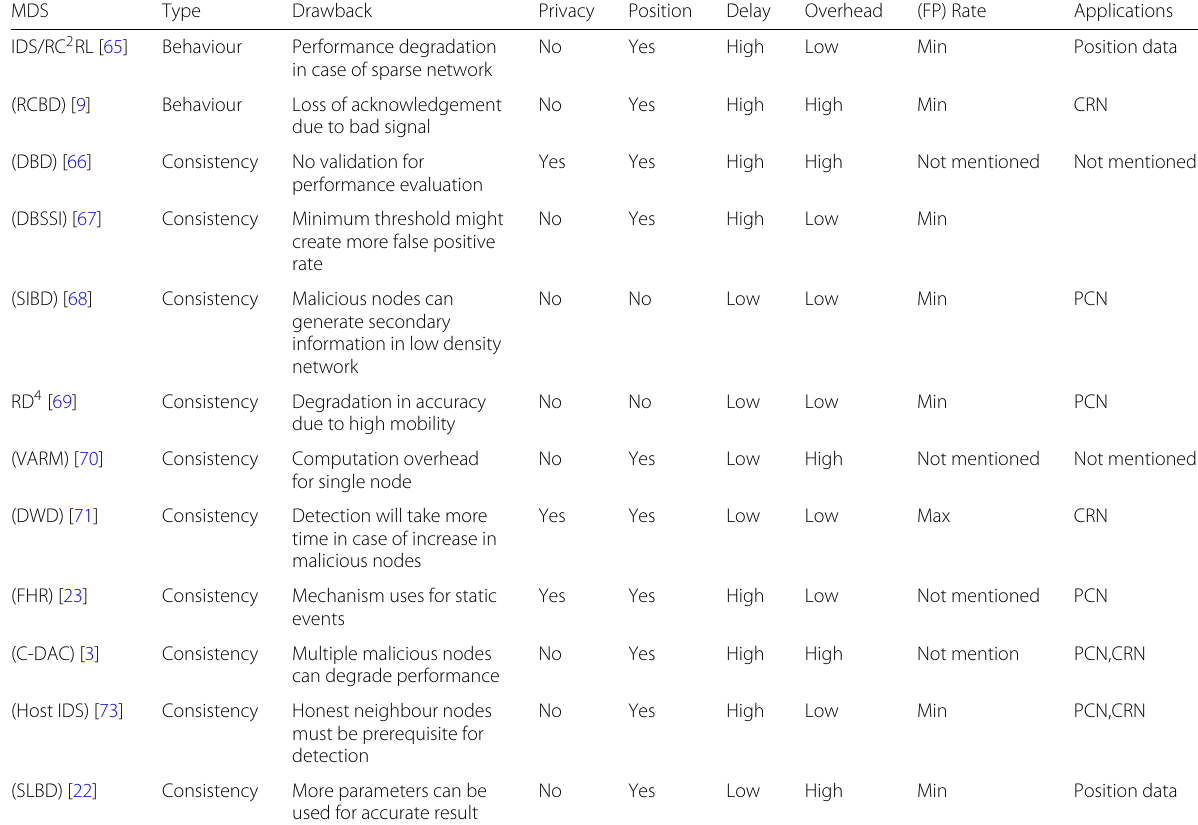
Table 2 Cooperative-based detection schemes MDS Type Drawback Privacy Position Delay Overhead (FP) Rate Applications